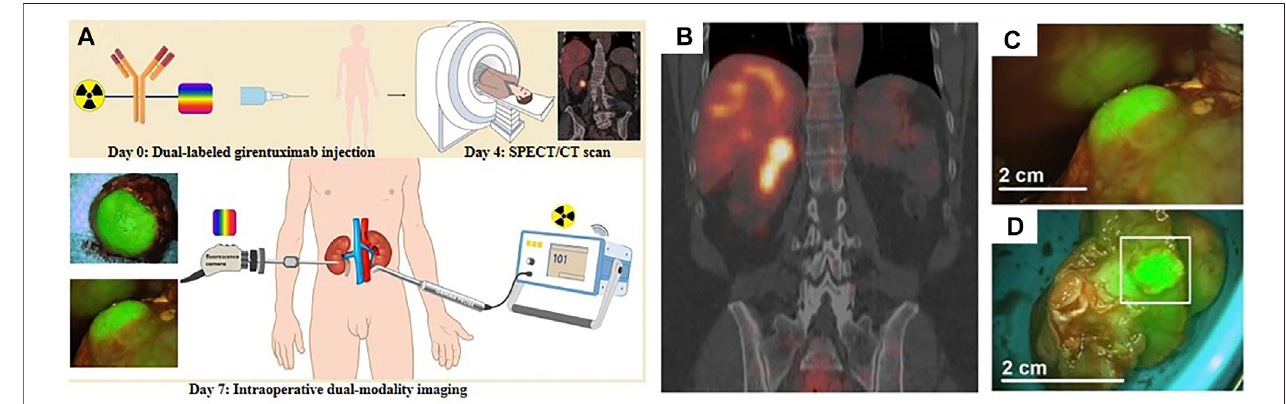
FIGURE 1 | (A) Schematic illustration of 111 In-DOTA-girentuximab-IRDye800CW in clinical applications. (B) Preoperative SPECT/CT imaging of patient #11 after injection of 111 In-DOTA-girentuximab-IRDye800CW. (C) Intraoperative FI of patient #11. (D) Assessment of the resected tumor specimen with FI (patient #11). Reproduced with permission from Hekman et al. (2018). Copyright 2018, Ivyspring International